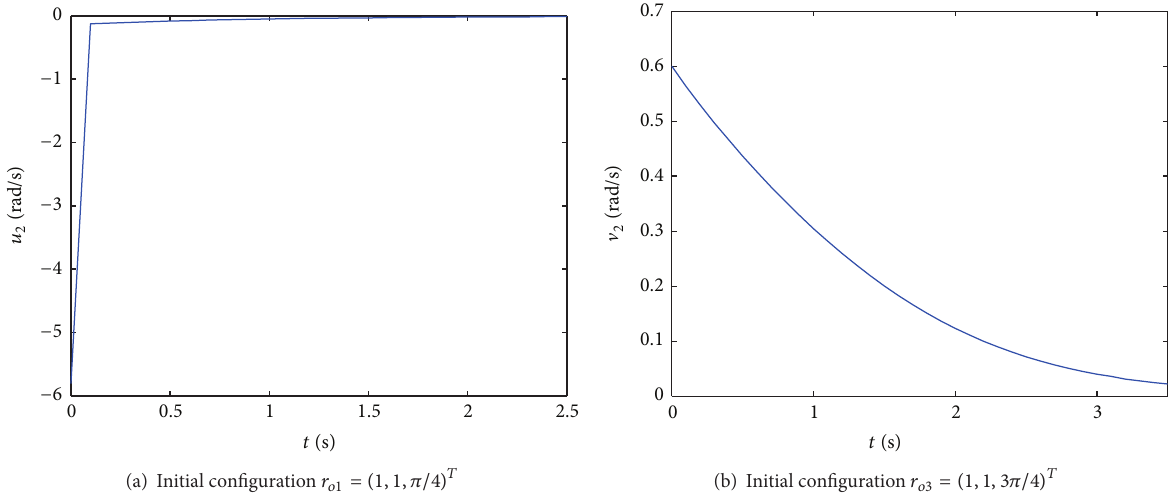
Figure 7: The first step. (a) is in the initial configuration 𝑟 𝑜1 = (1,1, 𝜋/4) 𝑇 , (b) is in the initial configuration 𝑟 𝑜3 = (1,1, 3𝜋/4) 𝑇 , and these figures show the regular velocity V 2 of the robot in the first